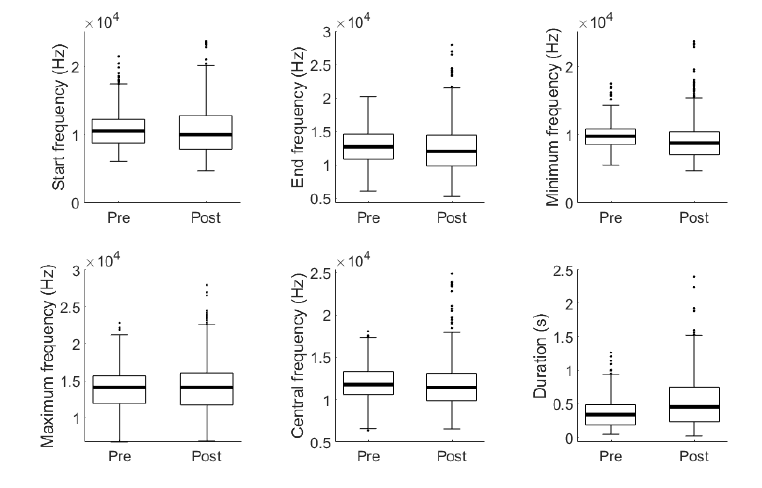
Figure 10. Box and whisker plots of whistle features before and after the detonation event. In the box plot, the horizontal thick black line indicates the median; the lower and upper box edges reflect the first and third quartiles; each whisker extends to a maximum of 1.5 inter-quartile range from the box edge. The black dots are the